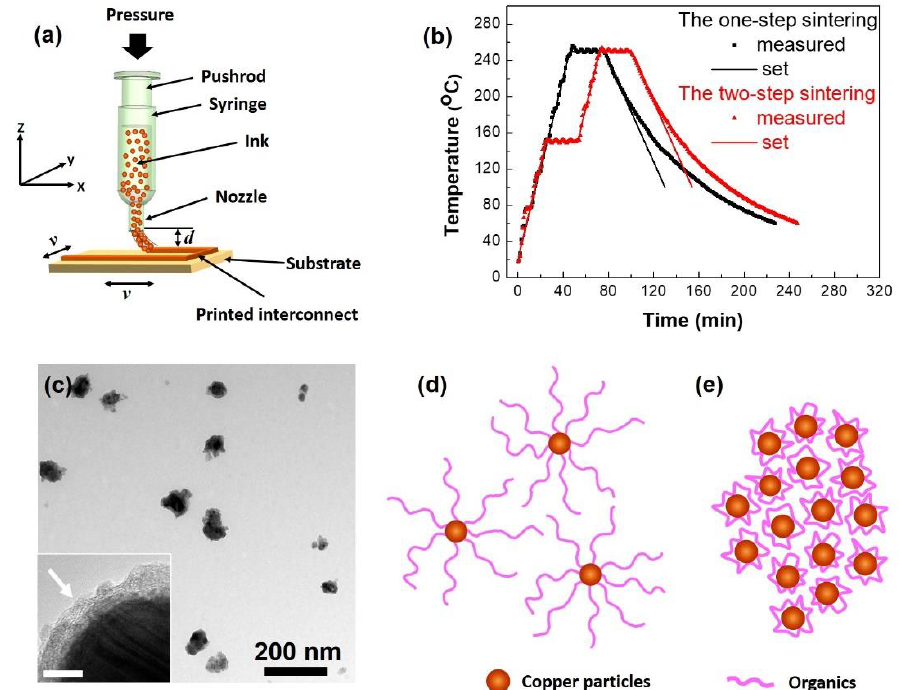
Figure 1. ( a ) A schematic picture of the home-made direct-writing installation. ( b ) The temperature profiles set and measured for both the one-step and two-step sintering strategies. ( c ) A typical TEM image of the nano-copper particles. The inset in ( c ) is a high resolution TEM image of a particle. The organic layer capped around the particle is pointed out by a white arrow. The scale bar in the inset stands for 5 nm. ( d ) Particles dispersed in the ink solvent by the steric hindrance effect as the organic chains extended fully and ( e ) particles aggregated when the organic chains curled up.